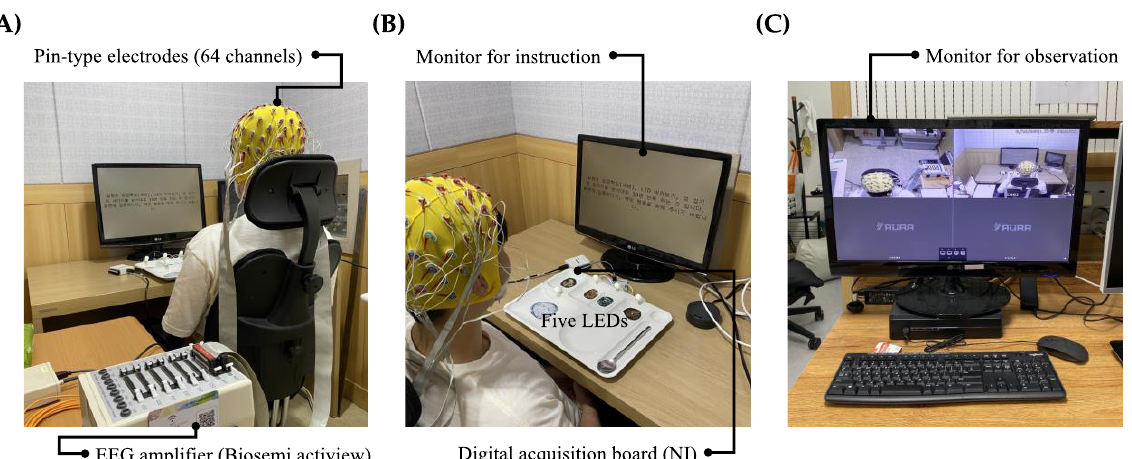
Figure 1. Experimental setup. (A) Device for EEG acquisition (EEG amplifier and 64 channels pin-type electrodes). (B) Monitor for instruction, a tray with five LEDs connected to digital acquisition board. (C) Monitor for observation.